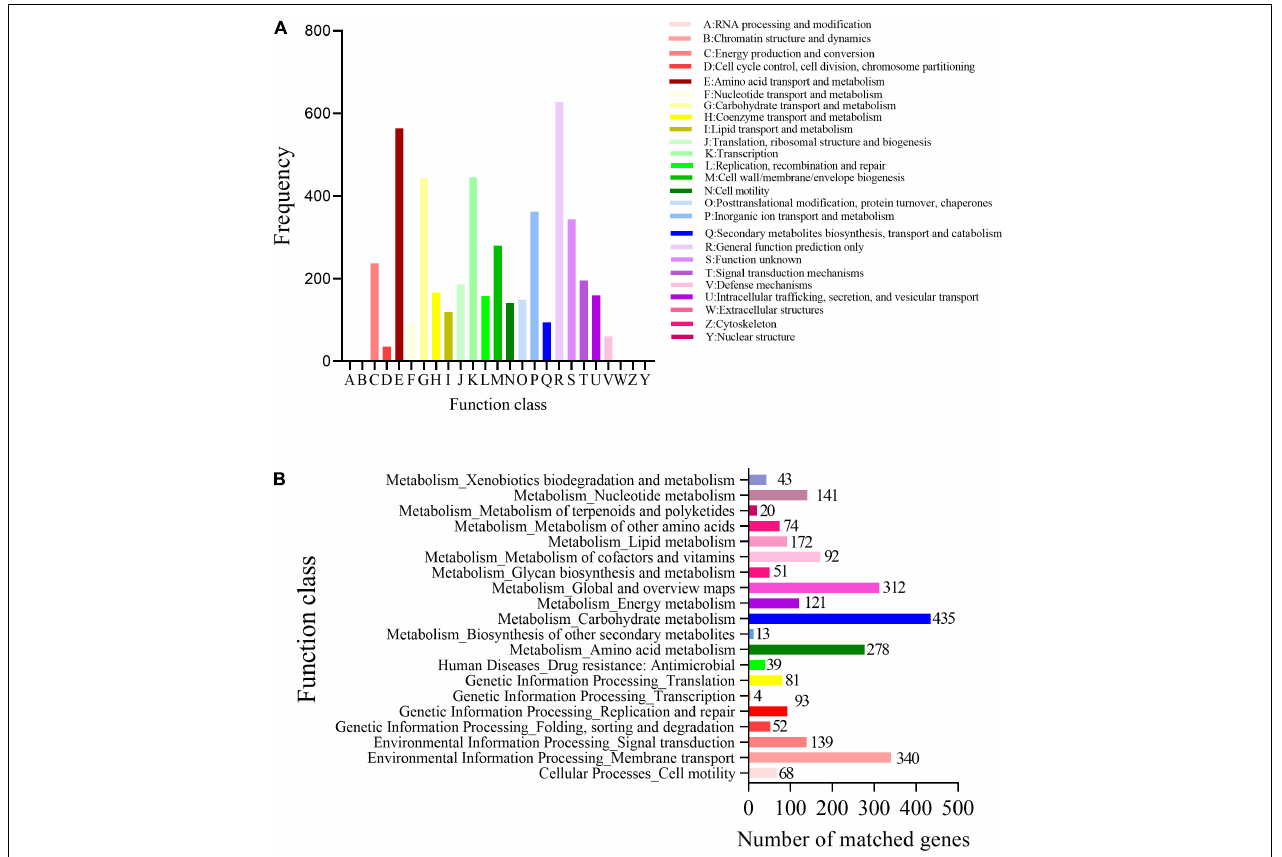
FIGURE 3 | Functional categories of R. victoriana JZ-GX1. (A) Clusters of Orthologous Groups of proteins (COGs) annotation and (B) Clusters of kyoto encyclopedia of genes and genomes (KEGG) annotation.